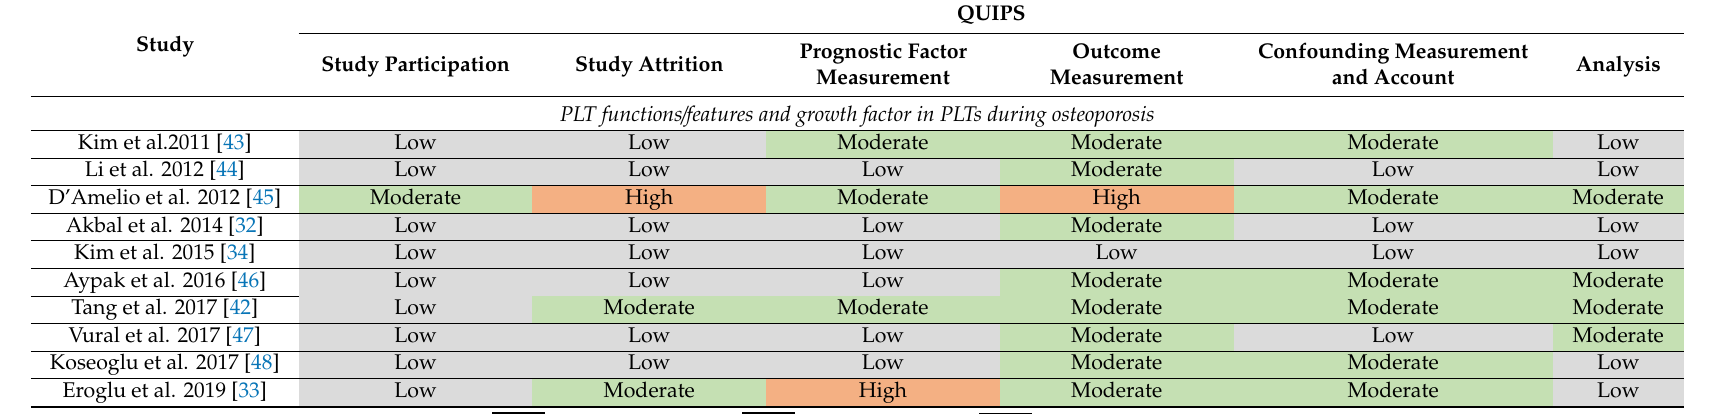
Table 4. QUIPS tool for assessing risk of bias in the clinical studies.